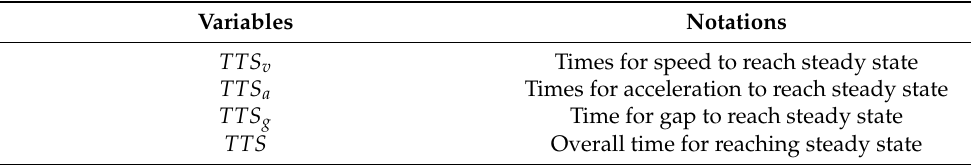
Table 5. Notations of CACC evaluation